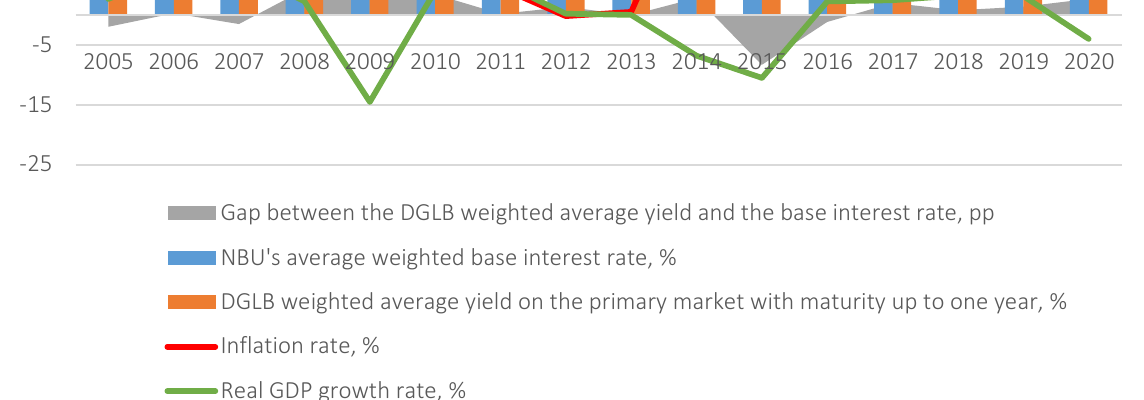
Gap between the DGLB weighted average yield and the base interest rate, pp NBU's average weighted base interest rate, % DGLB weighted average yield on the primary market with maturity up to one year, % Inflation rate, % Real GDP growth rate, Figure 8. Values of indicators reflecting the influence of the MTM interest rate channel